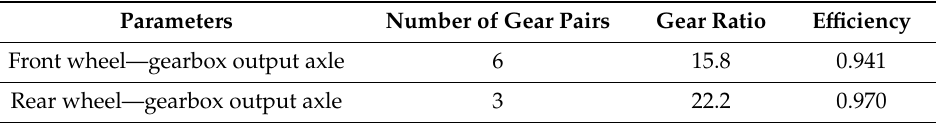
Table 3. Number of gear pairs, gear ratio, and efficiency between each wheel and gearbox.